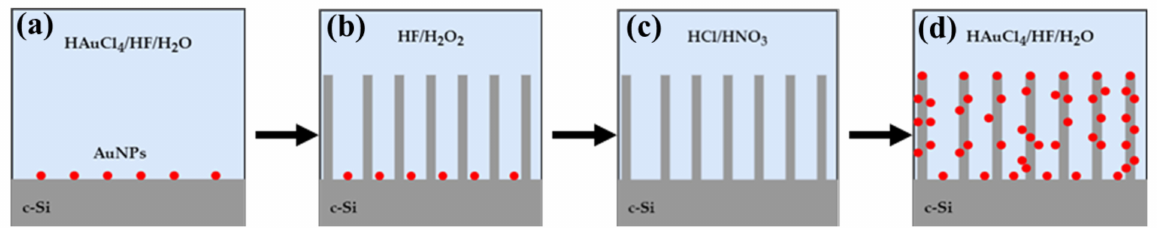
Figure 1. Schematic illustration of the fabrication process of SiNWs:Au-NPs: ( a ) deposition of catalytic Au-NPs on c- Si surface in HAuCl 4 /HF/H 2 O; ( b ) Au-NP-assisted etching with the HF/H 2 O 2 solution; ( c ) removal of residual Au-NPs in HCl/HNO 3 solution; ( d ) deposition of Au-NPs from HAuCl 4 /HF/H 2 O into SiNW arrays.